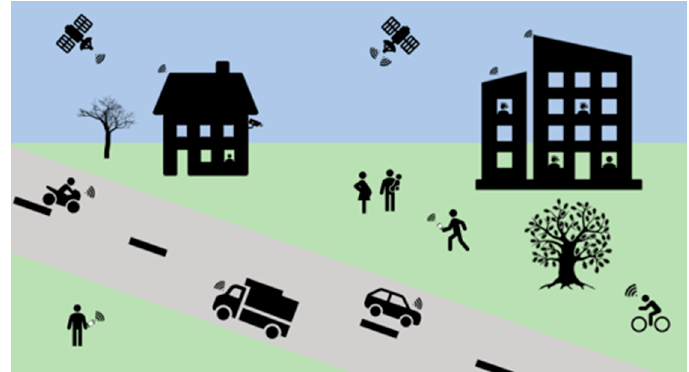
Figure 1. Smart city/Internet of Things (IoT) scenario and satellite communications.